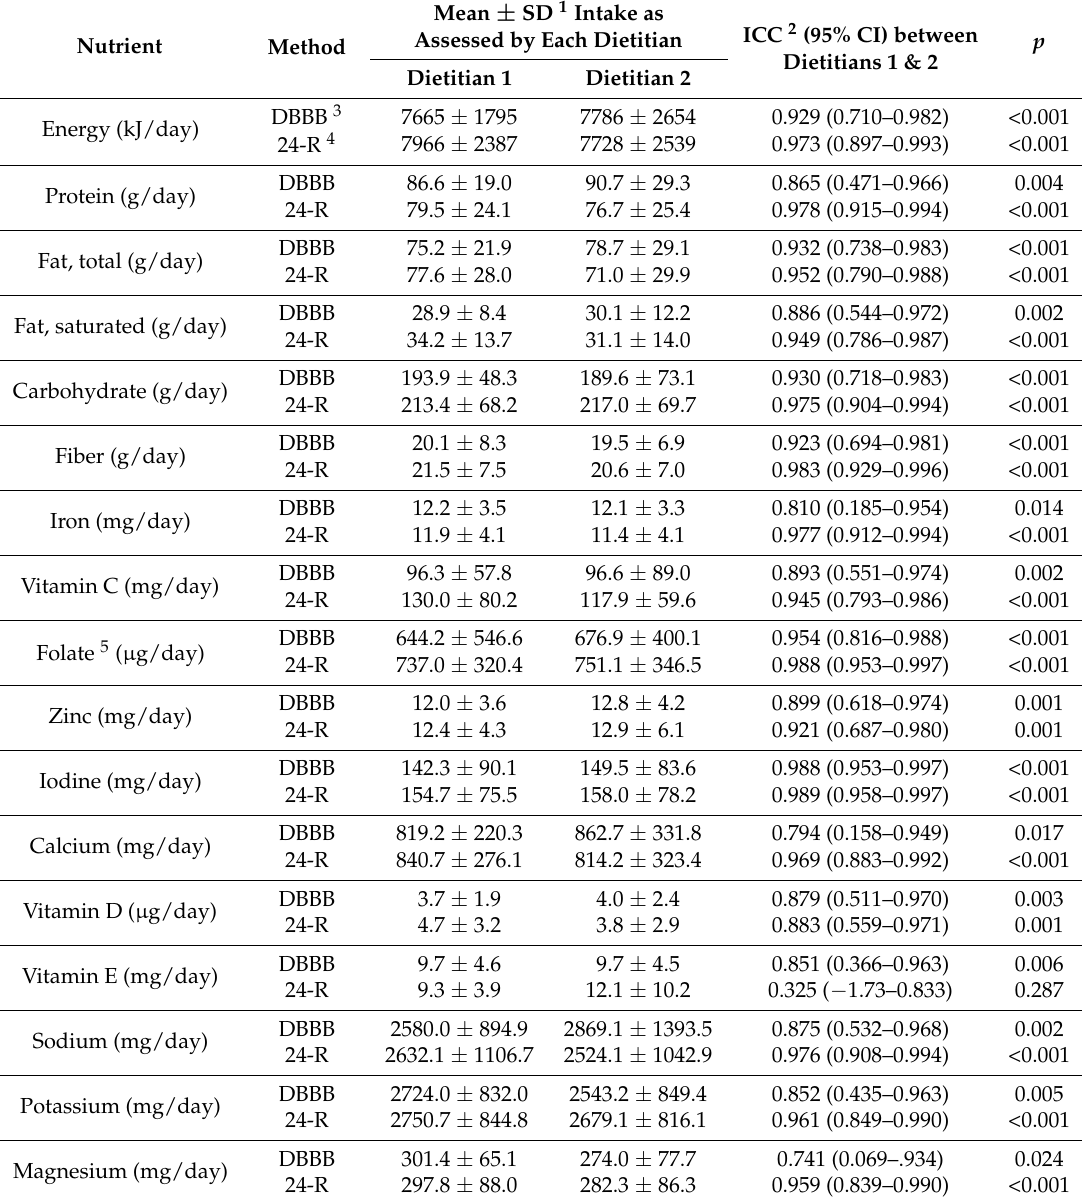
Table 3. Inter-rater reliability of energy and nutrient intake from the Diet Bytes and Baby Bumps image-based dietary records and 24-h recalls between two dietitians (for n = 10